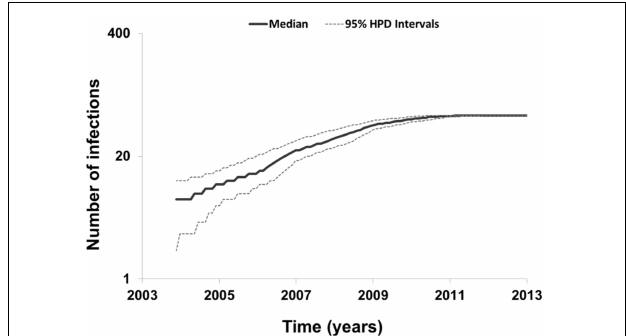
FIGURE 3 | Bayesian skyline plot estimated by BEAST v1.8.0 using birth-death models for the largest HIV-1 CRF02_AG subepidemic in Spain, showing the cumulative number of lineages (infections) in a logarithmic scale over time (median and 95% Highest Posterior Density-HPD intervals estimates).